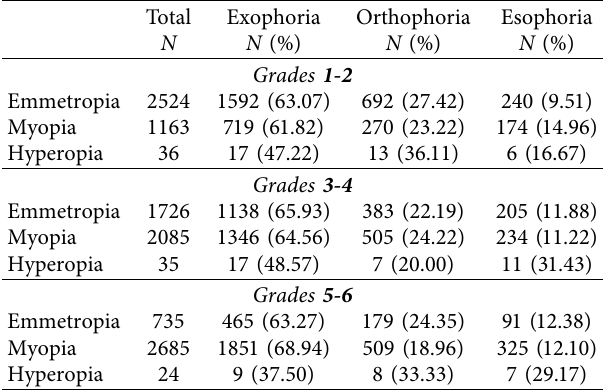
Figure 2: Degree of near heterophoria according to grade level. The degree of near heterophoria was compared with different grade-level groups using the Kruskal–Wallis H test ( P Table 2: Number and proportion of near heterophoria cases among children with different refraction.